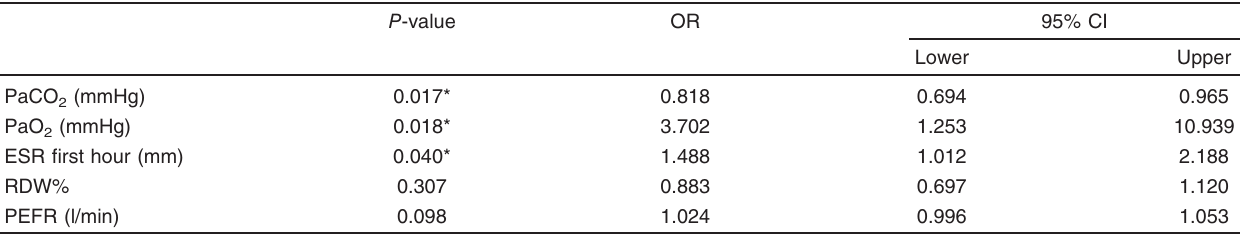
Table 4 Predictors of treatment failure among chronic obstructive pulmonary disease patients